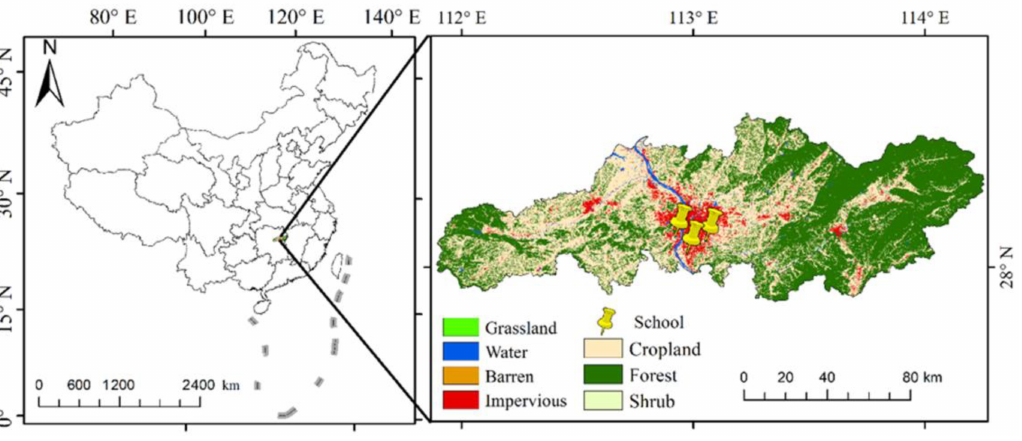
Figure 2. The study